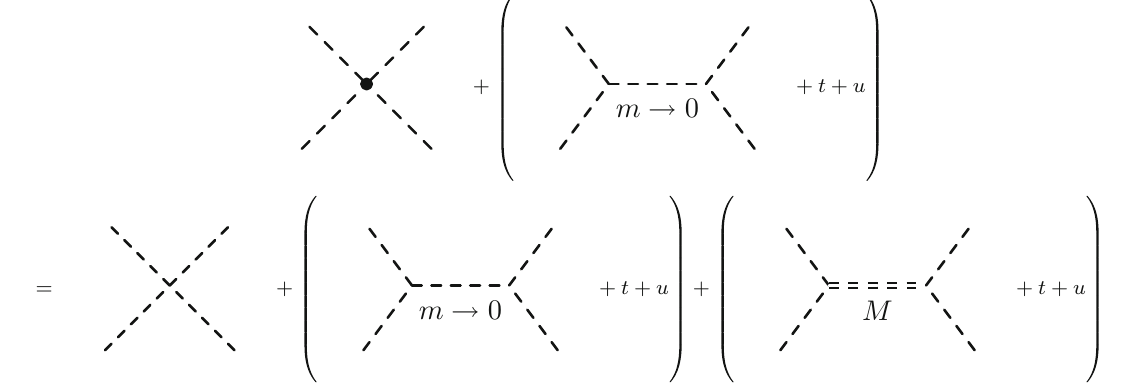
Fig. 1 Matching of quartic couplings at tree-level. Light scalars are drawn with a single dashed line, heavy scalars with a double dashed